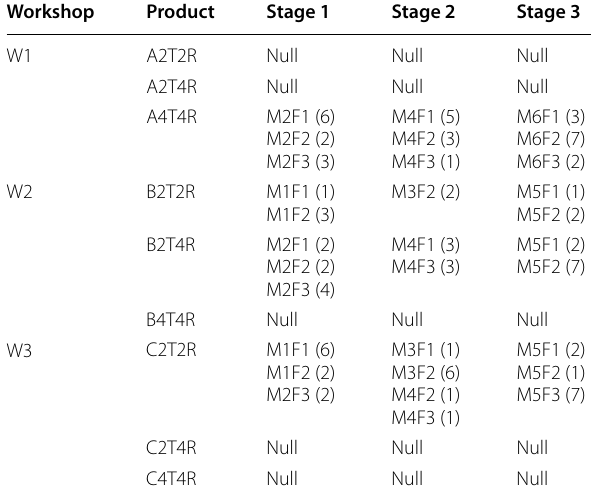
Table 11 Allocation scheme at Point A